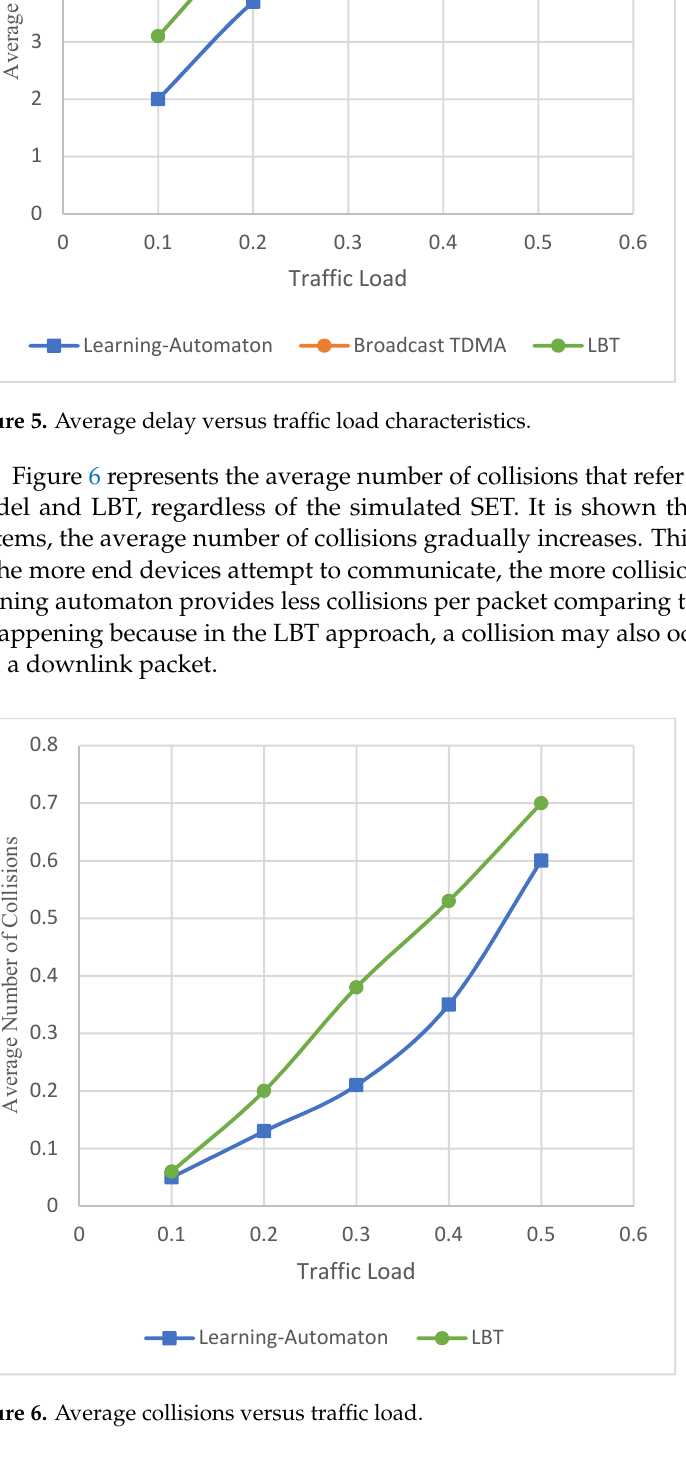
Figure 7. Packet success ratio versus traffic load.